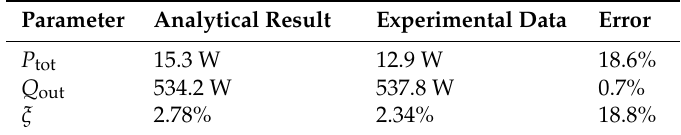
Table 6. Comparison between the analytical results and experimental